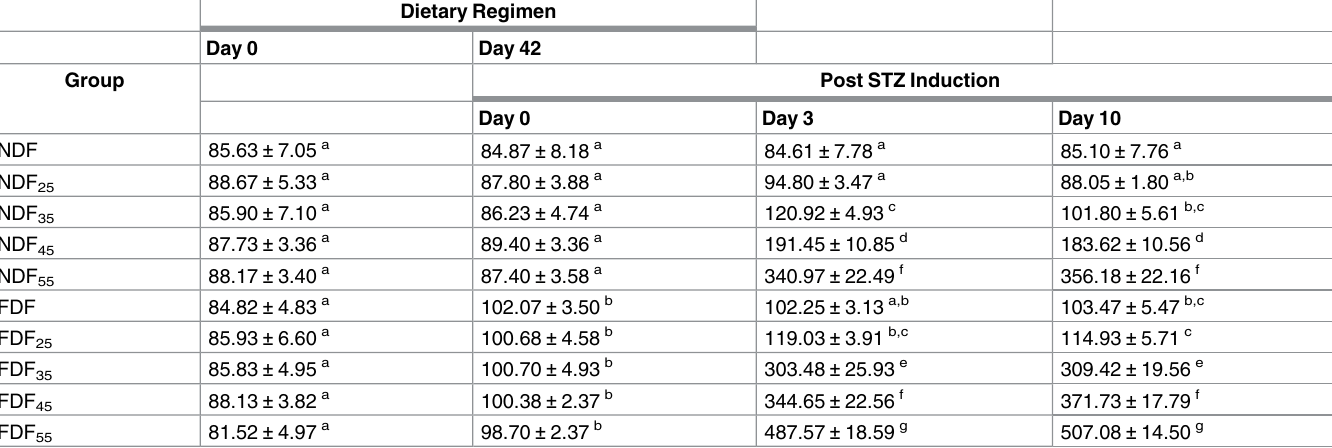
Table 2. Non-Fasting Blood Glucose (mg/dL) after Dietary Regimen and STZ Induction. Dietary Regimen